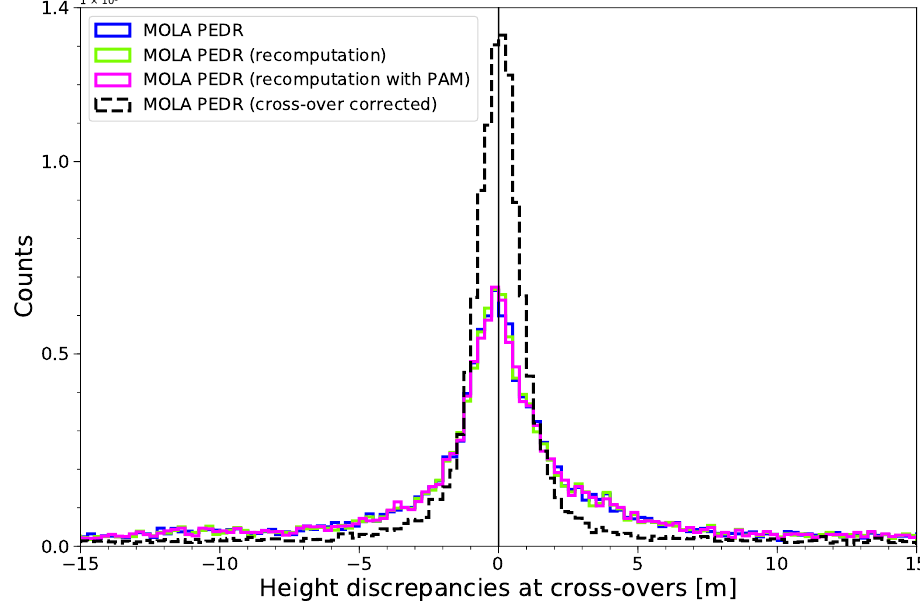
Figure 7. Histograms of the height discrepancies at cross-overs for the PEDR (blue), recomputed PEDR (lime), recomputed PEDR corrected for pointing aberration (magenta), and cross-over-corrected PEDR (dashed black) at 82 ◦ S to 85 ◦ S and 0 ◦ to 360 ◦ E in the Martian south